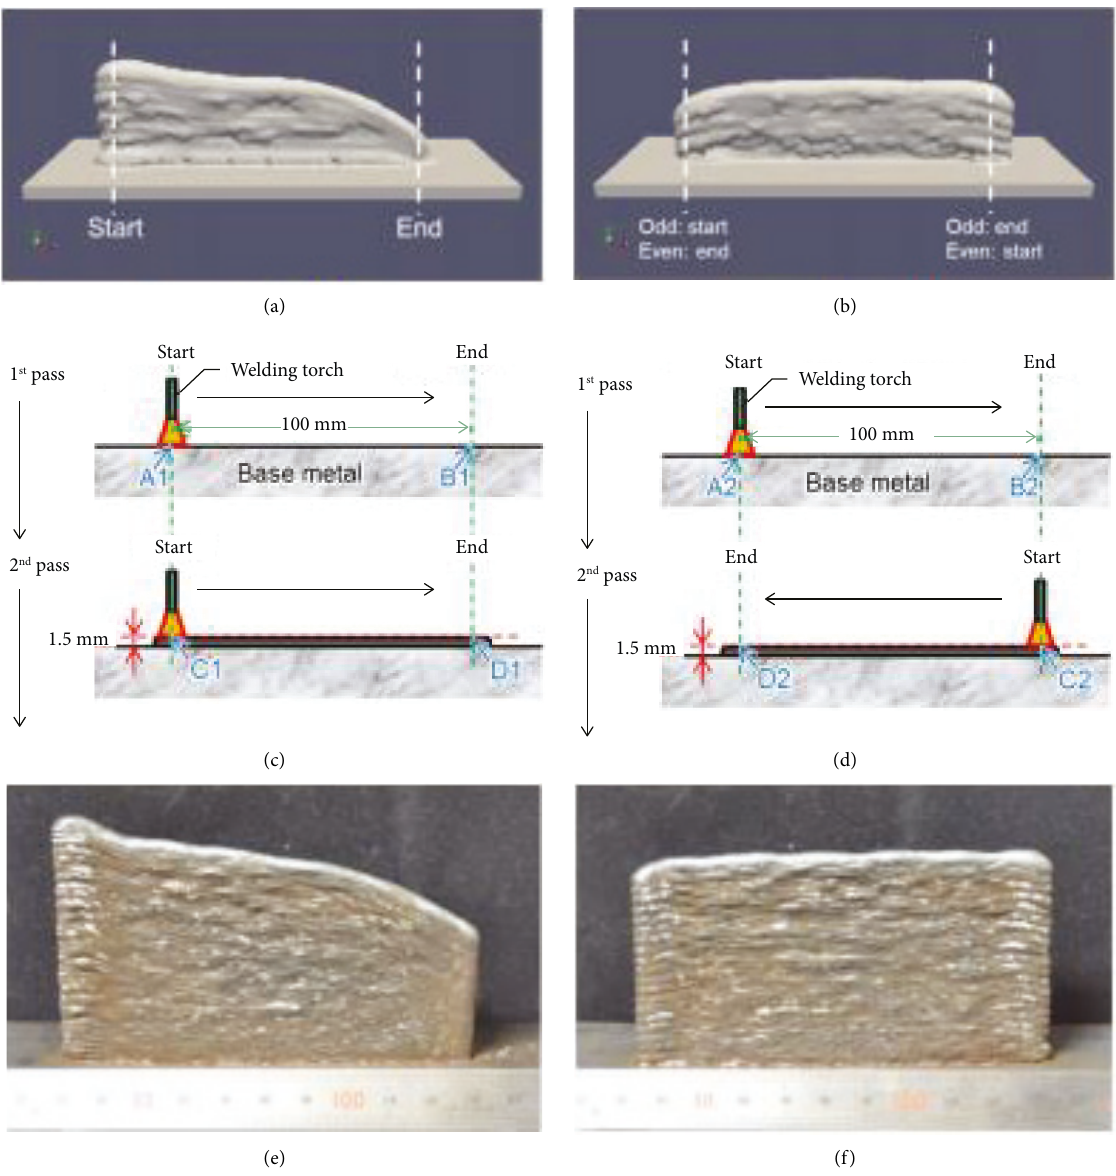
Figure 20: Numerical results of the deposition shape with different welding directions. (a) Pattern L-A. (b) Pattern L-B. Schematic images of welding tor\sition shape with different welding directions. (c) Pattern L-A. (d) Pattern L-B. Experimental results of the deposition shape with different welding directions. (e) Pattern L-A. (f) Pattern